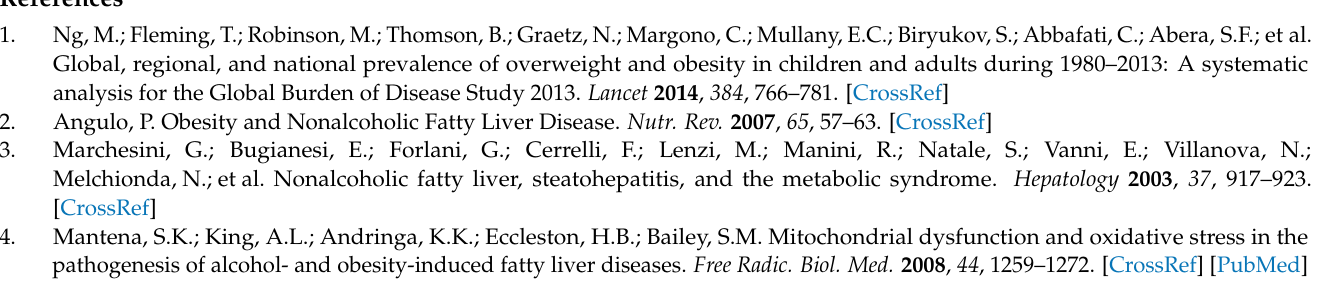
groups. Figure S4: TAG content of ZFL cell in FA, FA + HT and FA + HT + Csa